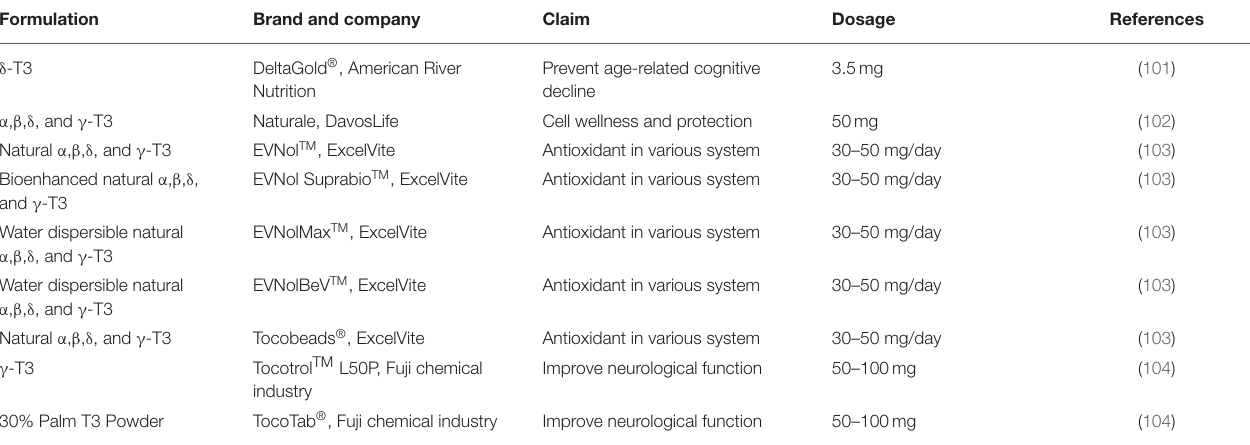
TABLE 3 | T3s-based products for